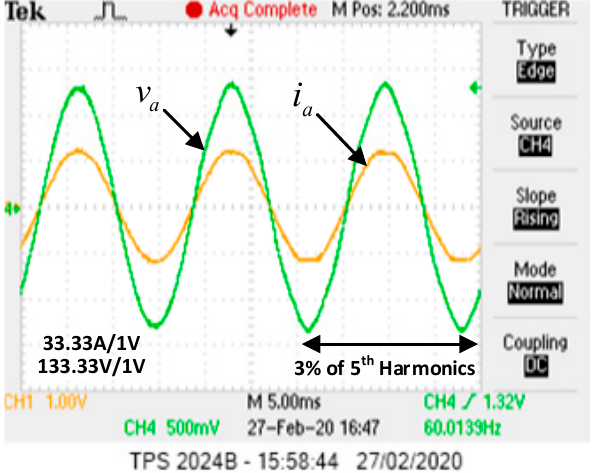
Figure 24. Voltage and current for phase A during inclusion of 3% of the 5th harmonic in the grid voltage (120 Vrms and Pref = 10 k Qref = 0).